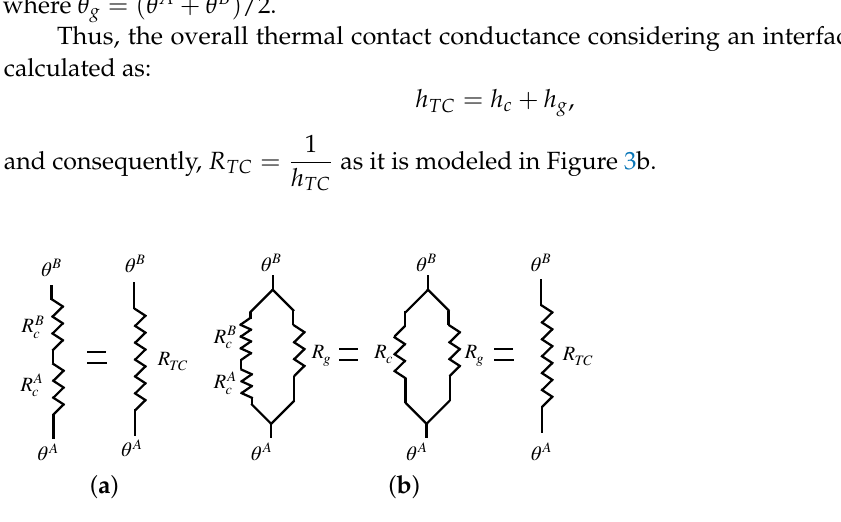
Figure 3. ( a ) Equivalent thermal contact resistance model for no TIM consideration. ( b ) Equivalent thermal contact resistance model for TIM consideration.